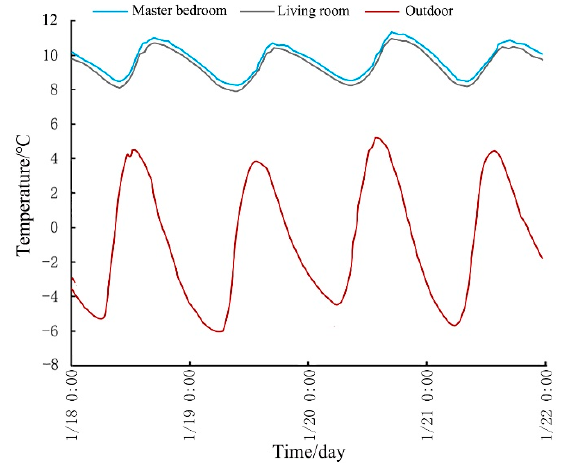
Figure 26. The temperature of Rural House 2 after the renovation.